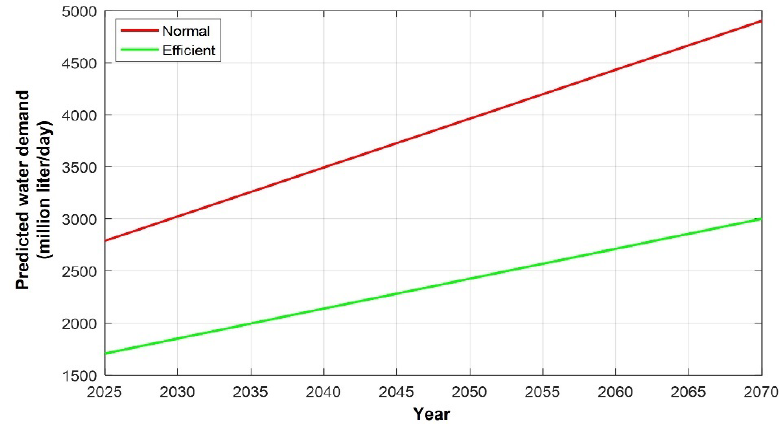
Figure 11. Predicted demand for water per day with and without system loss.